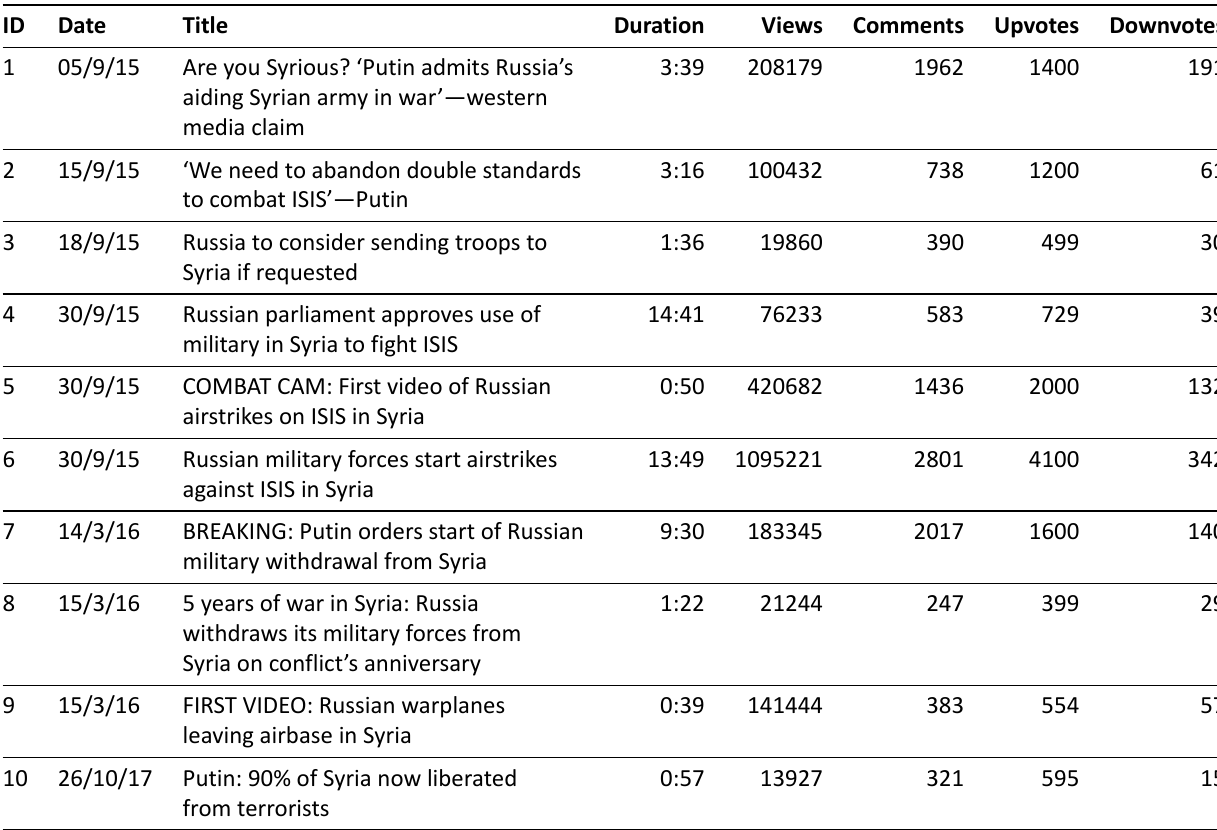
Table 2. RT videos announcing Russian intervention (videos 1–6) and the withdrawal of Russian forces (videos